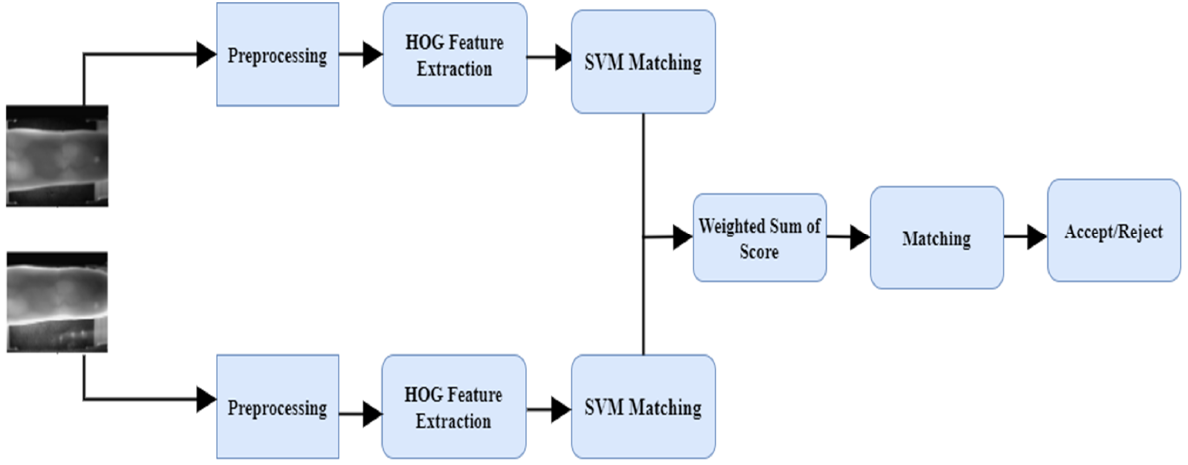
Figure 1. The Proposed Bayesian optimized SVM Score Fusion (BSSF) .